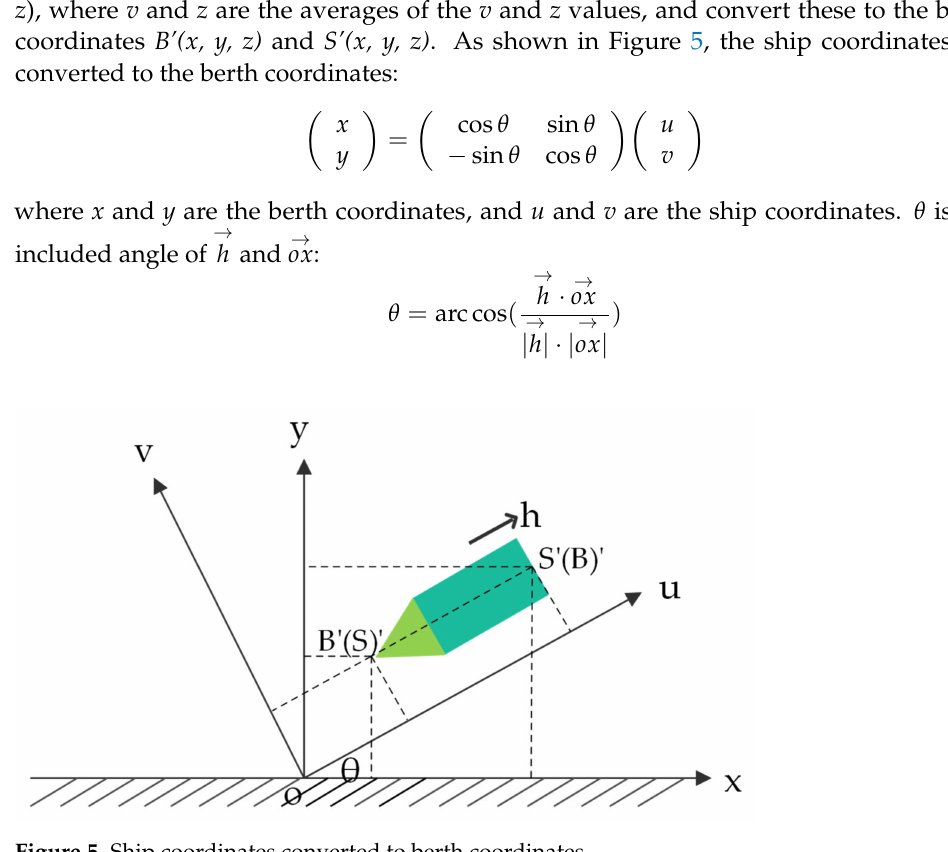
Figure 5. Ship coordinates converted to berth